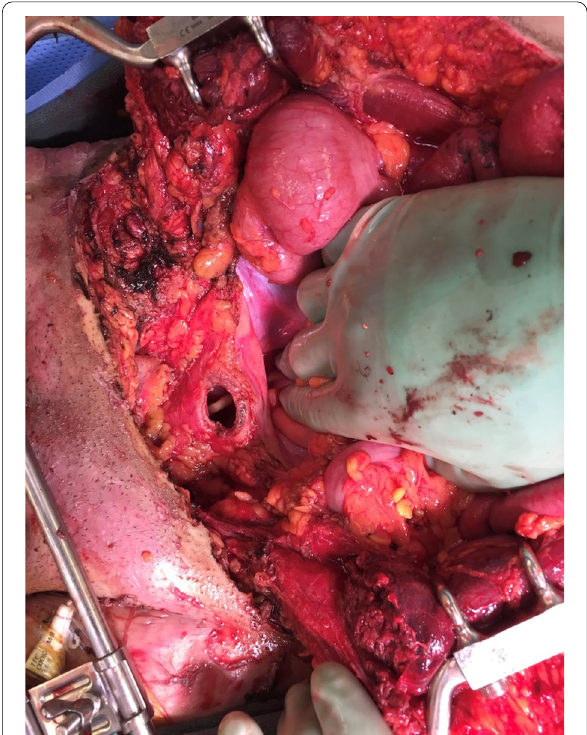
Fig. 6 Intraperitoneal bladder perforation secondary to electrical